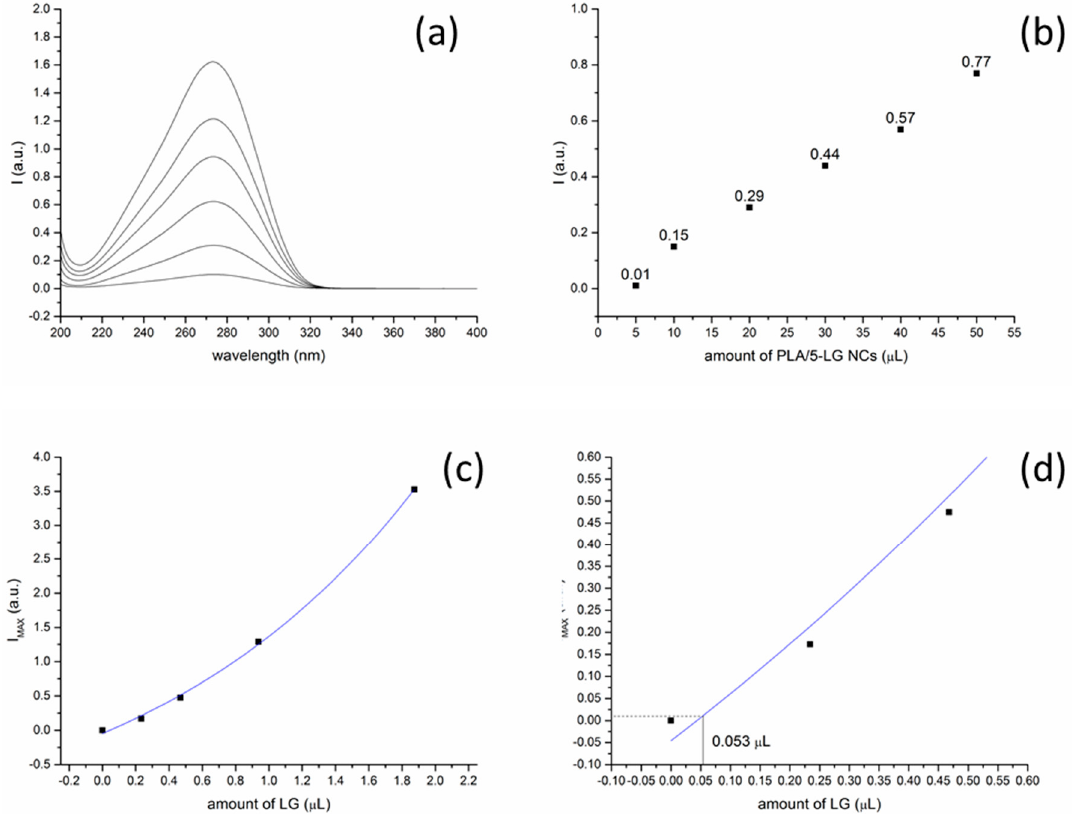
Figure 4. ( a ) UV absorption spectra of increasing amount of PLA/5-LG NCs solution (5, 10, 20, 30, 40 and 50 µ L): the peak at 275 nm corresponds to PLA while the shoulder at 240 nm corresponds to LG absorption; ( b ) intensities of the peak at 240 nm for increasing amounts of PLA/5-LG NCs; ( c ) calibration curve of LG essential oil; and ( d ) calculation of LG oil content in 5 µ L of PLA/5-LG NCs.